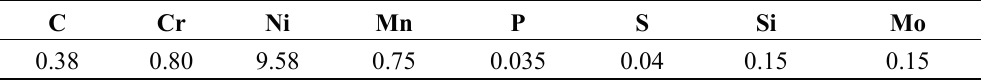
Table 2. Chemical composition of AISI 4140 alloy steel